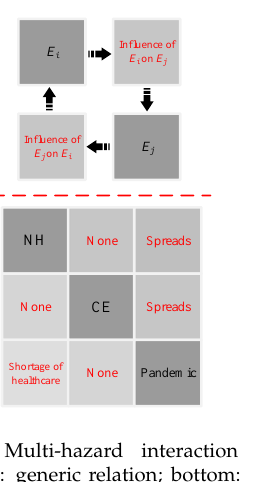
Figure 4. Matrix presentation of multi-hazard and